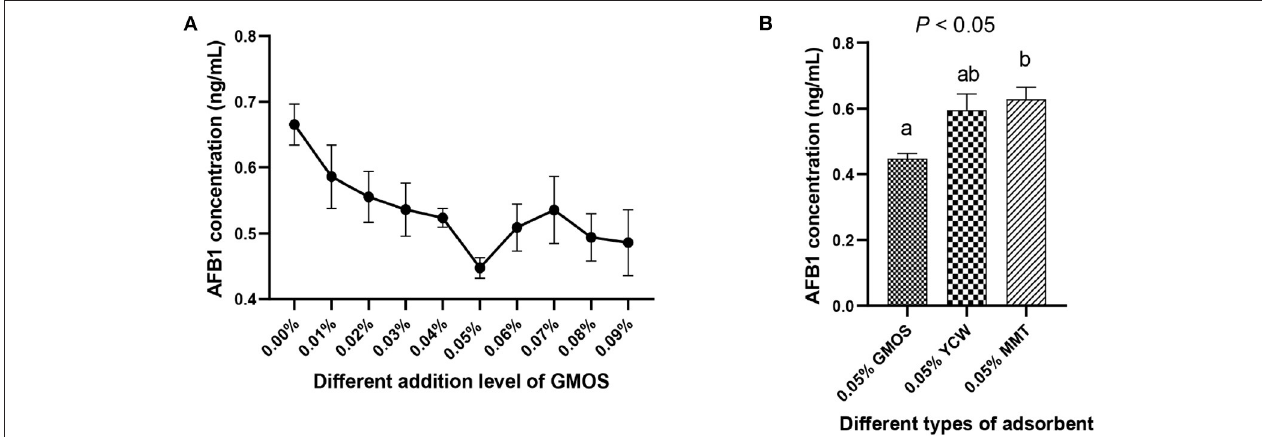
FIGURE 1 | The ability of GMOS to adsorb mycotoxins (Aflatoxins B1, AFB1), which were measured in vitro using ELISA. (A) Effects of different addition levels of GMOS (0.00, 0.01, 0.02, 0.03, 0.04, 0.05, 0.06, 0.07, 0.08, and 0.09%) on AFB1 concentration. (B) Effects of 0.05% GMOS, 0.05% Yeast cell wall (YCM), 0.05% Montesserstone (MMT) on AFB1 concentration. a,b Mean values within a row with different superscript letters were significantly different ( P < 0.05).